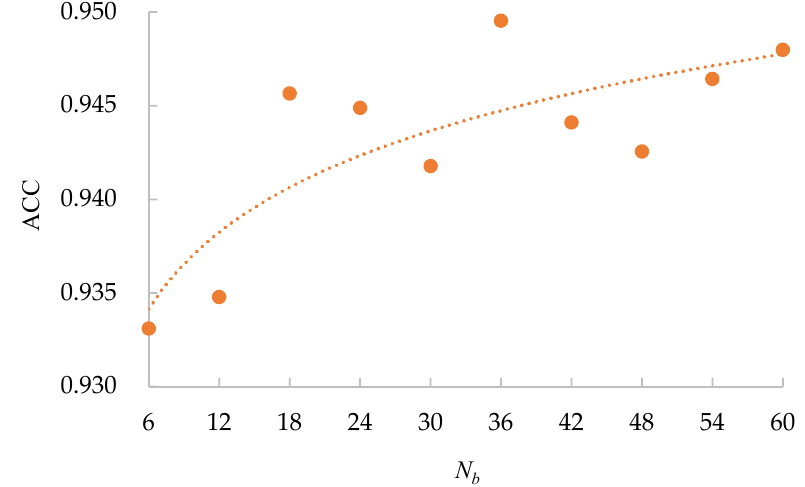
N on the Chest-1 dataset. Figure 5. Accuracy of MobileNet-V3-Small for different N b b on the Chest-1 dataset.